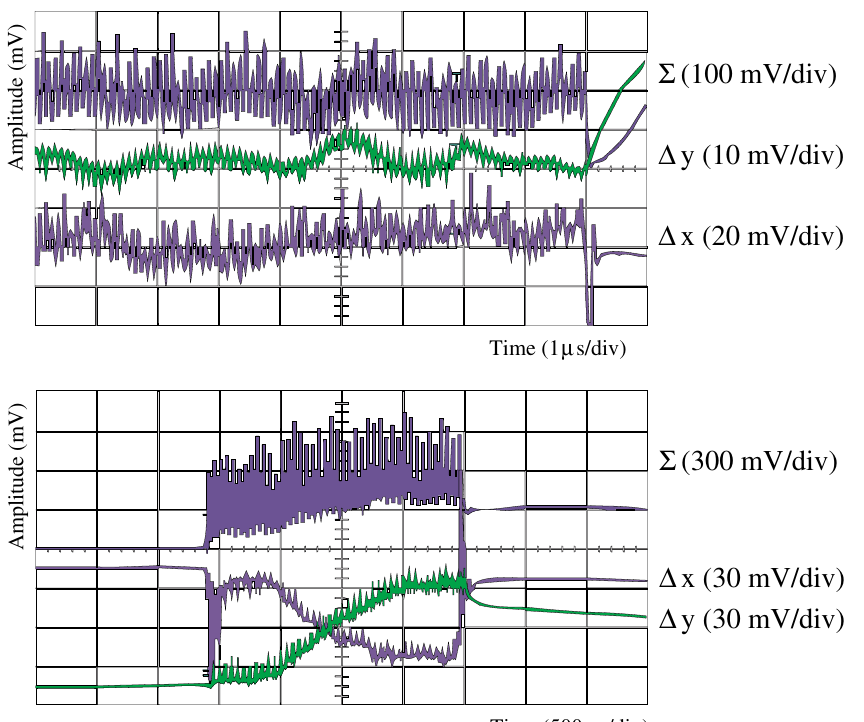
FIG. 7. (Color) Measured baseline drift in a PS electrostatic pickup in the last turns before extraction (upper panel) and in TT2 (lower panel) for the 25 ns spacing with 84 bunches (i.e., no gap). A strong electron cloud buildup is clearly visible. The spike on the (cid:24) x signal for the TT2 pickup is generated by the bunches badly ejected due to the finite rise time of the extraction